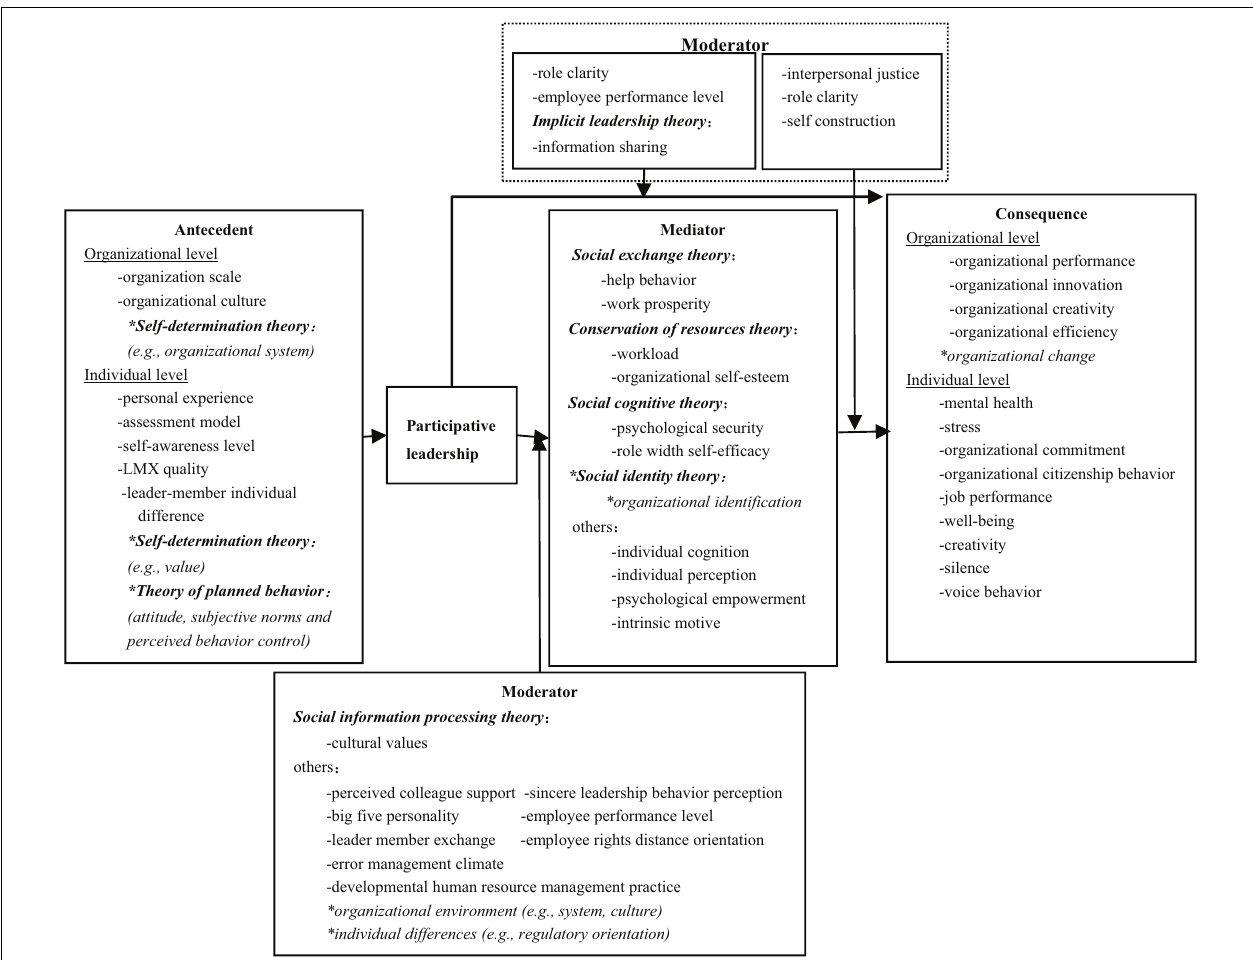
FIGURE 1 | Empirical research on participative leadership. Data sources were reviewed according to relevant literature; “-”represents the existing research path and variables; “*”represents the path and variables proposed in future